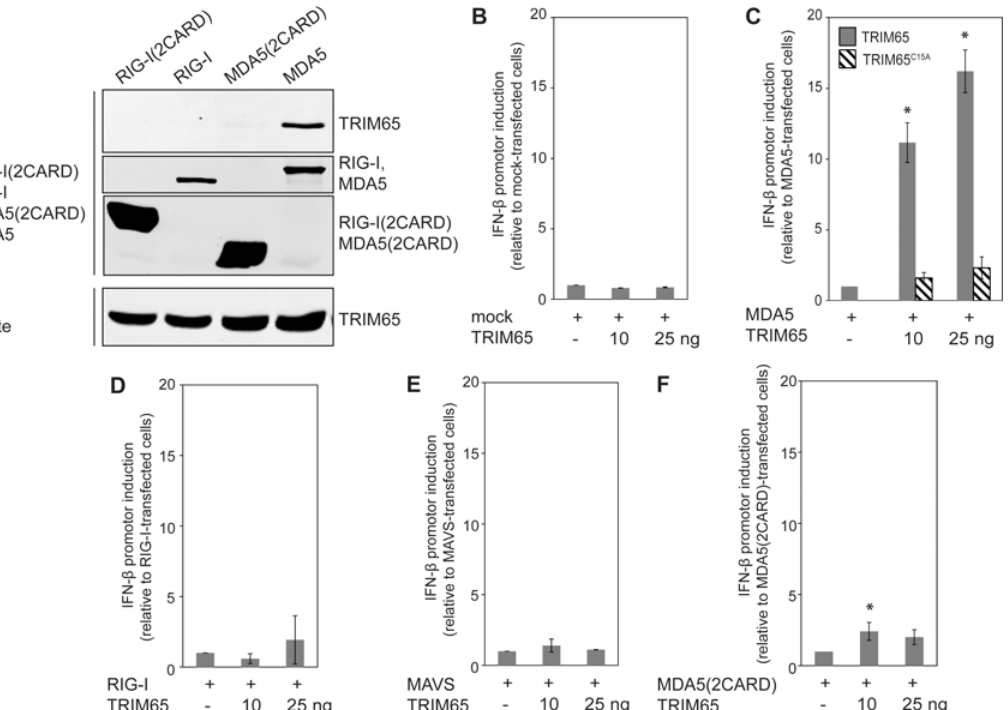
Fig 4. TRIM65 interacts with MDA5 and enhances MDA5-stimulated interferon- β expression. ( A ) FLAG-epitope-tagged RIG-I (2CARD) (the two CARD domains of RIG-I), RIG-I (full length), MDA5 (2CARD) (the two CARD domains of MDA5), or MDA5 (full length) were transiently expressed in HEK 293T cells together with M45-epitope-tagged TRIM65. Protein interactions were analyzed by immunoprecipitation with anti-FLAG and immunoblotting with anti-M45 and anti-FLAG antibodies. This experiment was repeated 3 independent times with similar results. ( B - E ) HEK293T cells were co-transfected with plasmids expressing TRIM65 or the catalytically-deficient TRIM65 C15A mutant along with plasmids expressing RIG-I (20 ng), MDA5 (50 ng), MDA5(2CARD) (10 ng) or MAVS (50 ng) as indicated, and the reporter plasmids expressing firefly luciferase under the control of interferon- β promoter and renilla luciferase (to standardize the transfection efficiency). The activation of the interferon- β promoter was analyzed 18 h after transfection by Dual Luciferase Reporter Assay System (Promega). Values represent the mean +/- standard deviation of the relative levels of normalized firefly luciferase from 3 independent experiments. The normalized firefly luciferase activity relative to mock-transfected cells was 10.5 ± 2.9 for MDA5 only transfected cells ( C ), 11.1 ± 4.8 for RIG-I only transfected cells ( D ), 30.6 ± 17.8 for MAVS only transfected cells ( E ), and 15.4 ± 3.3 for MDA5(2CARD) only transfected cell ( F ). * : indicates